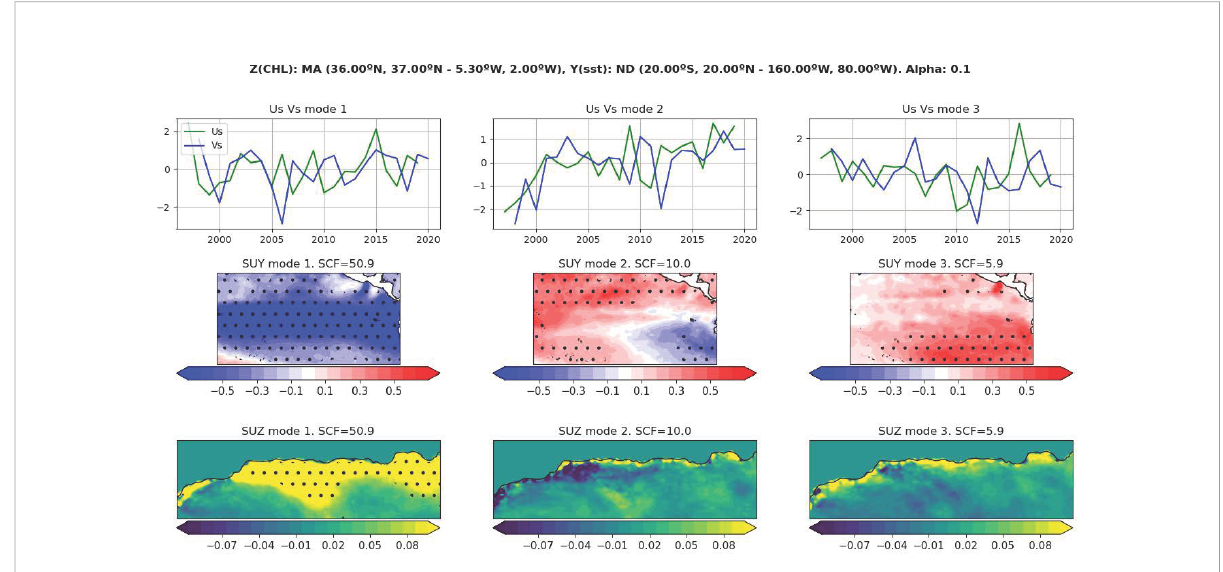
FIGURE 6 As Figure 5 but using the tropical Paci fi c SSTs in November – December (lag -4) as